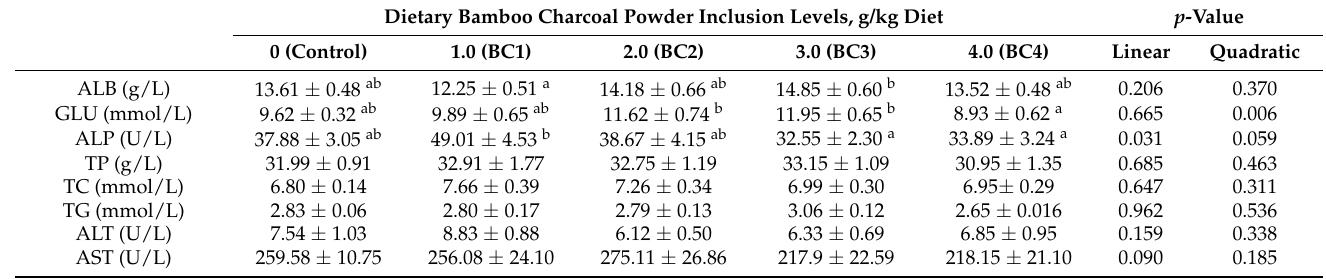
Table 5. Plasma biochemical parameters of blunt snout bream fed with the experimental diets 1 . Dietary Bamboo Charcoal Powder Inclusion Levels, g/kg Diet p -Value